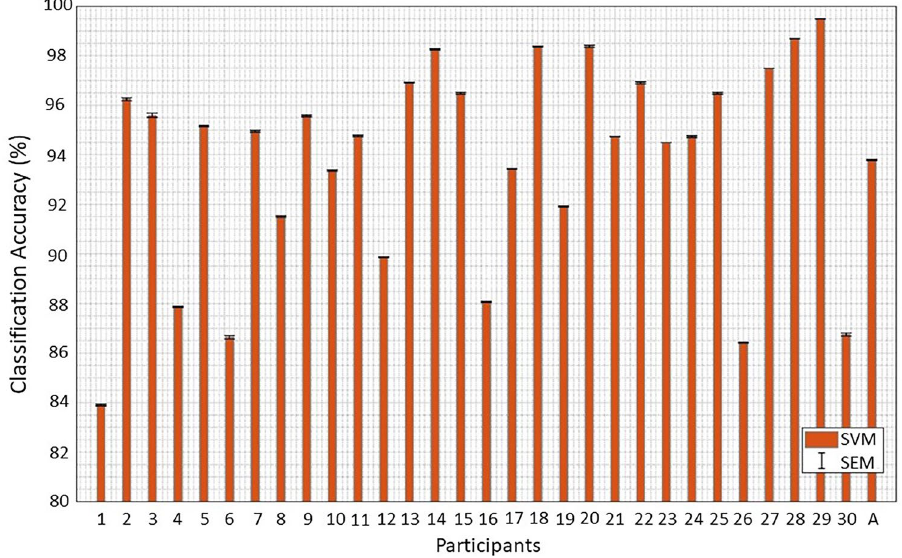
Figure. 5. Classification accuracies of individual subject and grand averaged classification accuracy between Session 1 (impulse buying) and Session 2 (non-impulse buying) using SVM. All participants show the accuracies in the range of 83.91–99.49%. These results suggest that fNIRS data can be used as a biomarker to differentiate between impulse and non-impulse buying behaviors in terms of the BCI